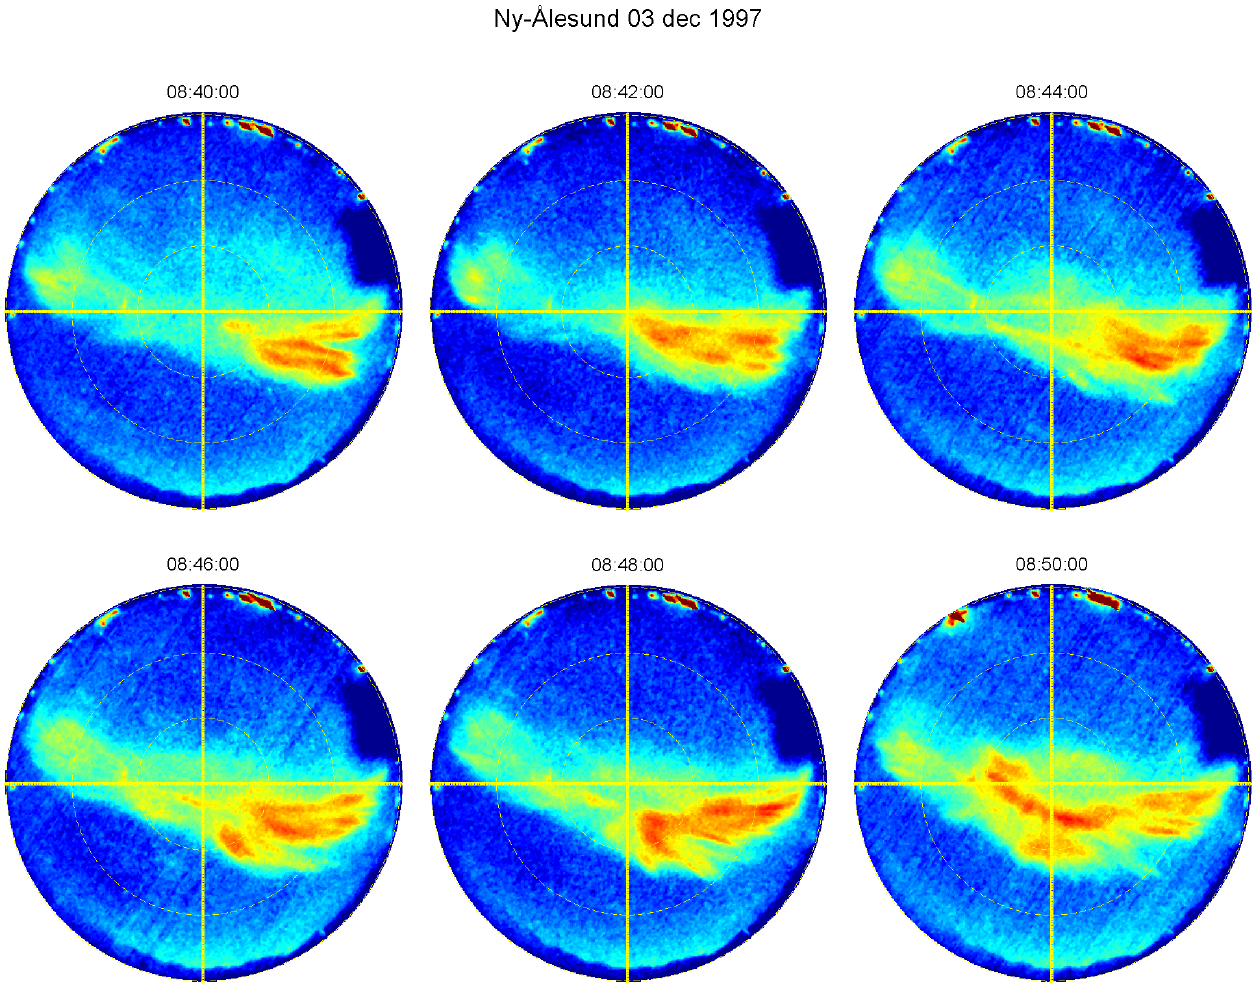
Fig. 6. ASC images at 630.0nm during interval 08:40–08:50UT. The central vertical line marks the ∼ 1200 MLT meridian. Same format as in Fig. 5.